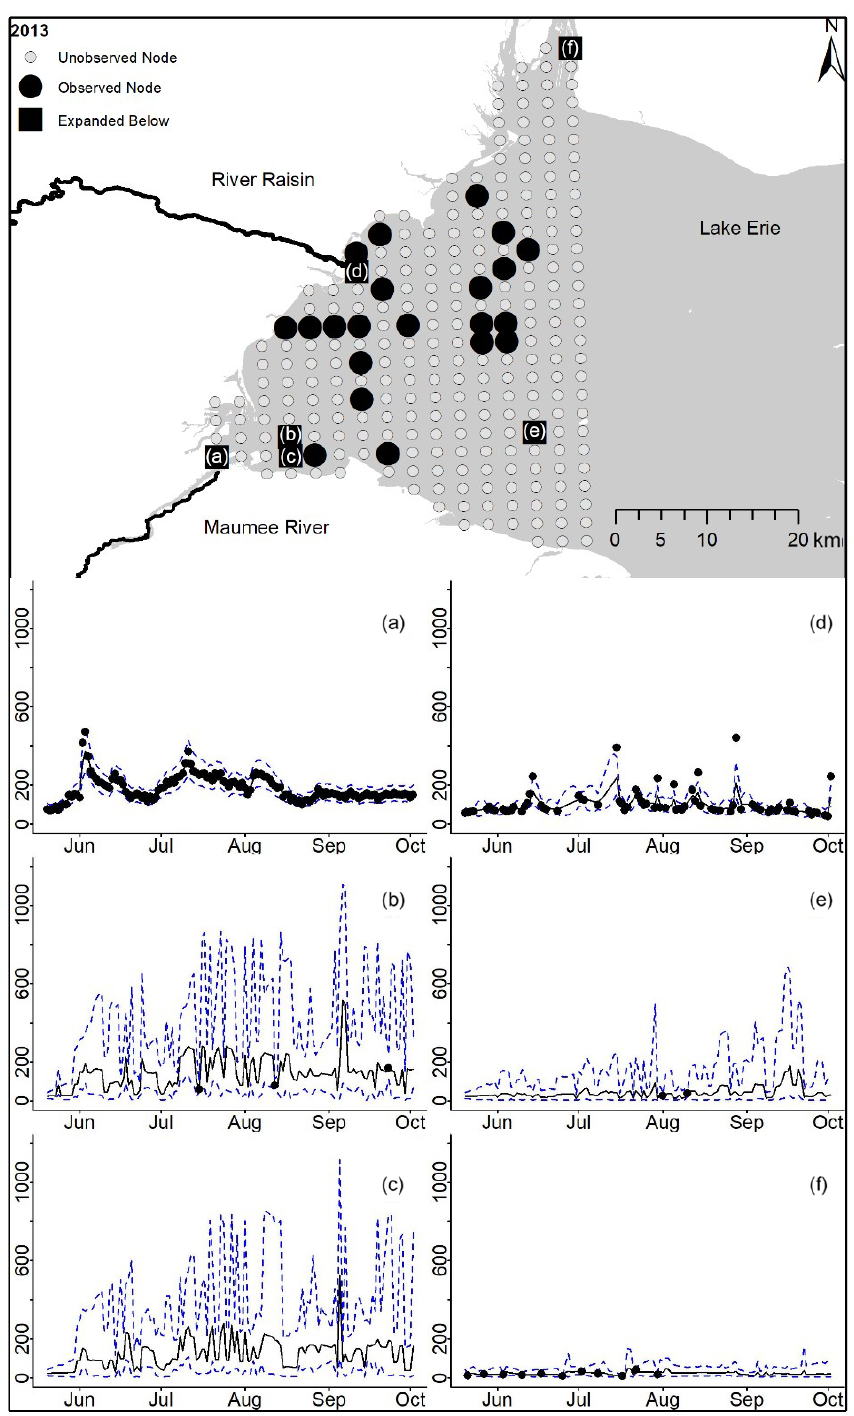
Figure D6. For 2013 the total phosphorus concentrations (µgL − 1 ) at observed and unobserved nodes were estimated from the model posterior samples. Mean (solid black line) and 95%PI (dashed blue line) for the model posterior samples of each node at every day for (a) the Maumee River, (b, c, e, f) western Lake Erie nodes, and (d) the Raisin